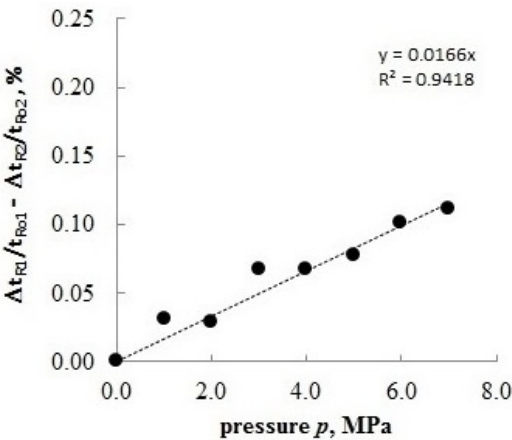
Figure 7. The difference in the relative changes in the travel time of URW in circumferential and axial